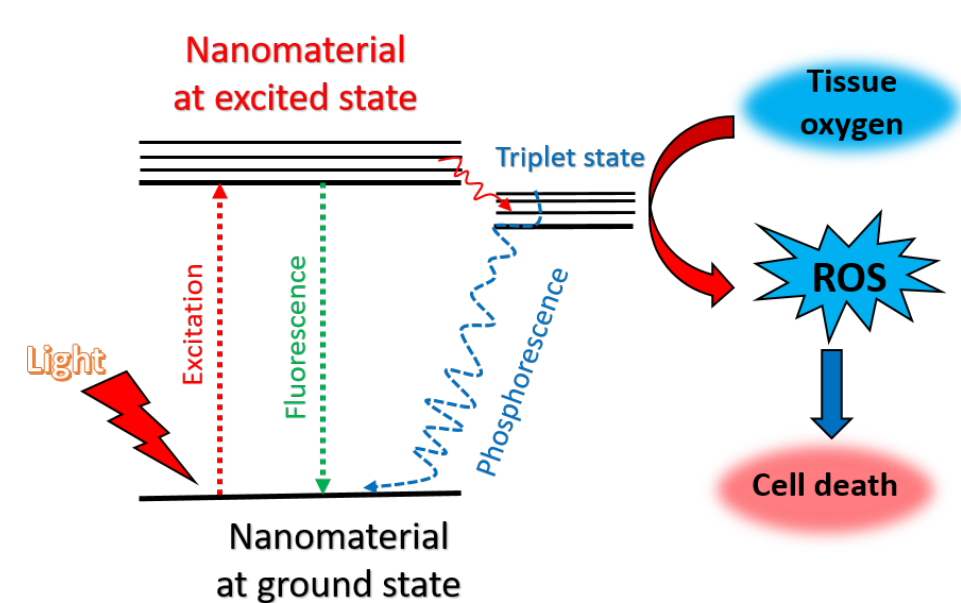
Figure 3. Mechanism of nanomaterials mediated photodynamic therapy .